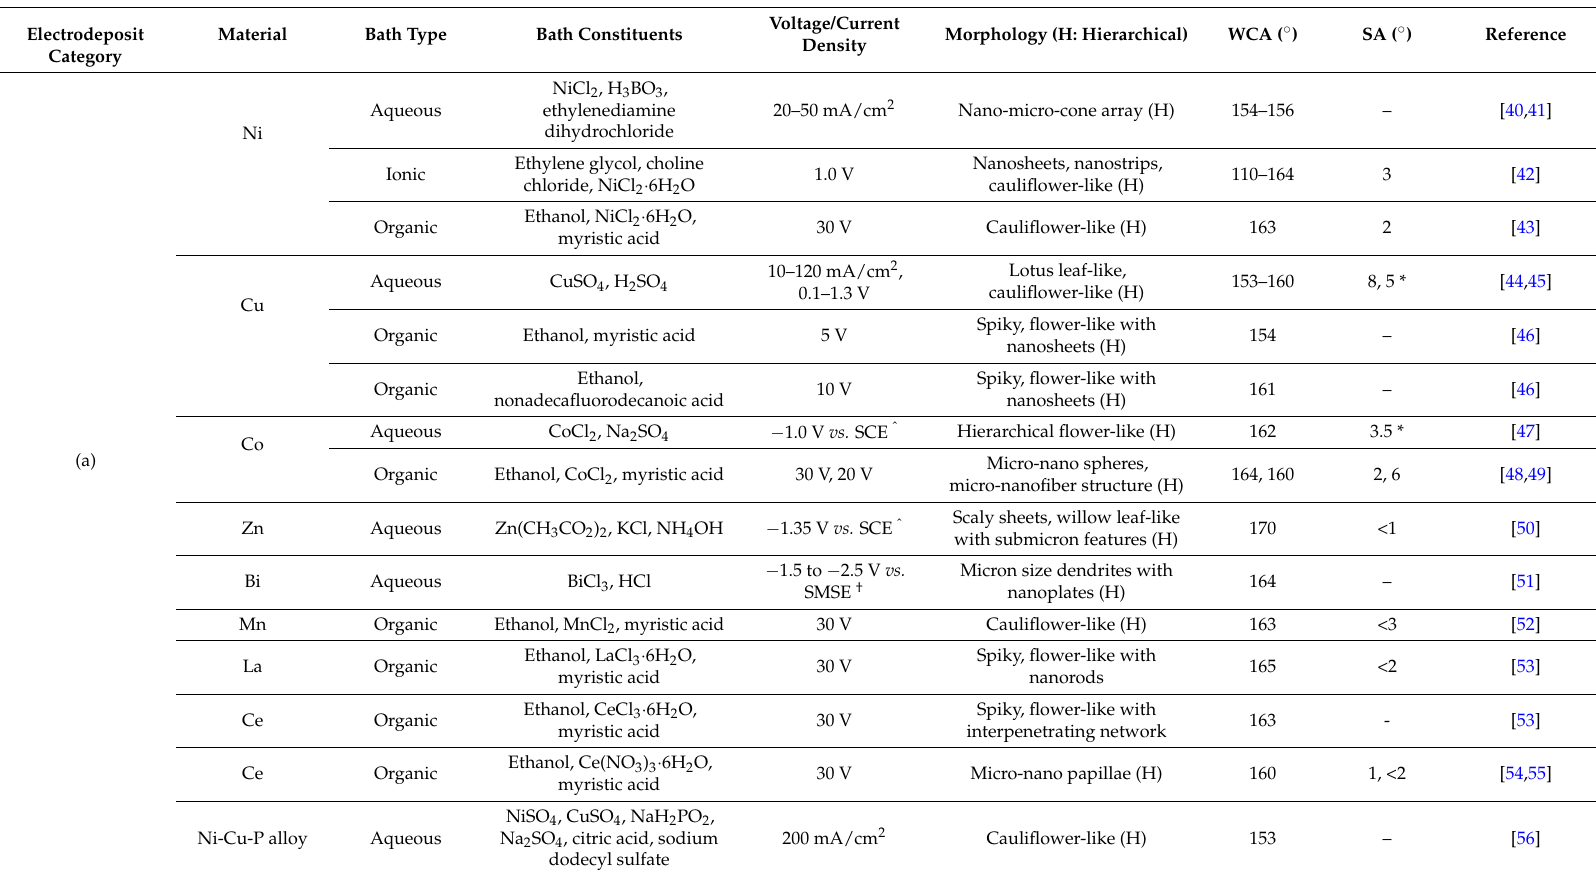
Table 1. Superhydrophobic electrodeposits, classified into 3 categories: ( a ) Electrodeposits with surface roughness (Section 3.1); ( b ) electrodeposits with surface roughness and chemical modifications (Section 3.2); ( c ) electrodeposits with second phase particles (Section 3.3). WCA, water contact angle; SA, sliding